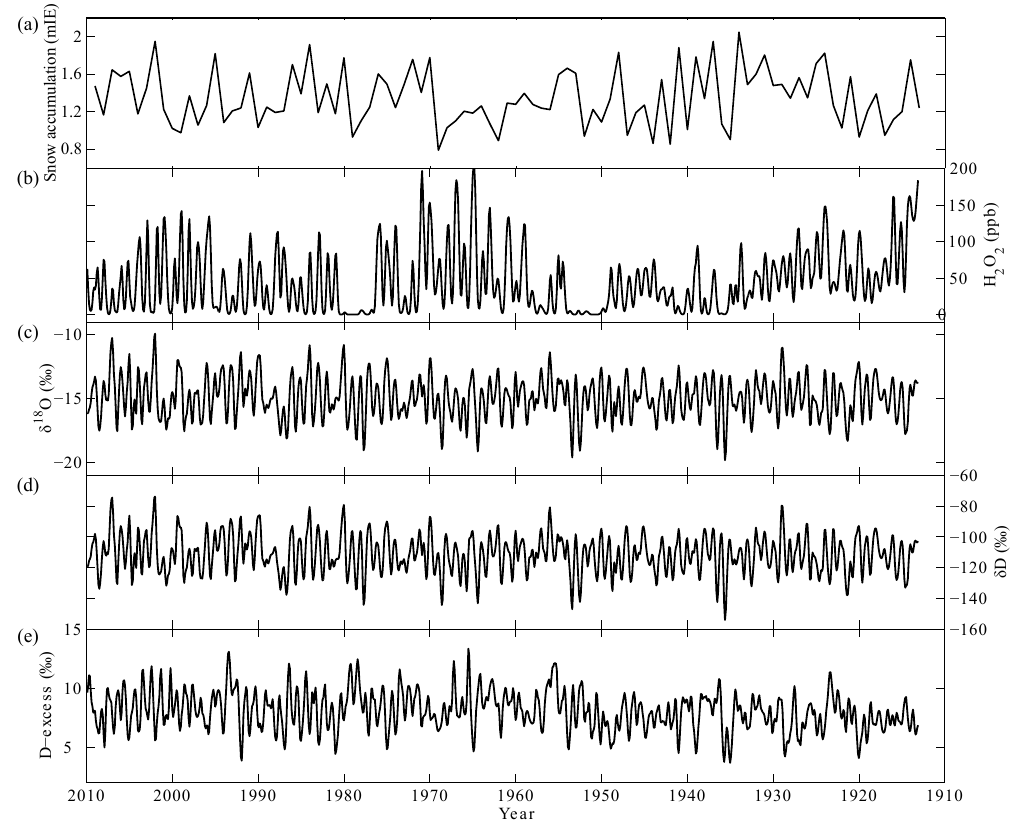
Figure 2. Ninety-seven-year record of annual snow accumulation (a) , H 2 O 2 (b) , δ 18 O (c) , δ D (d) , and D-ex (e) . All data except snow accumulation record were resampled to a 0.1-year grid and smoothed with a Gaussian filter of width σ = 1 point. Table 2. Mill Island ice core information. Ice core Lat Long Depth